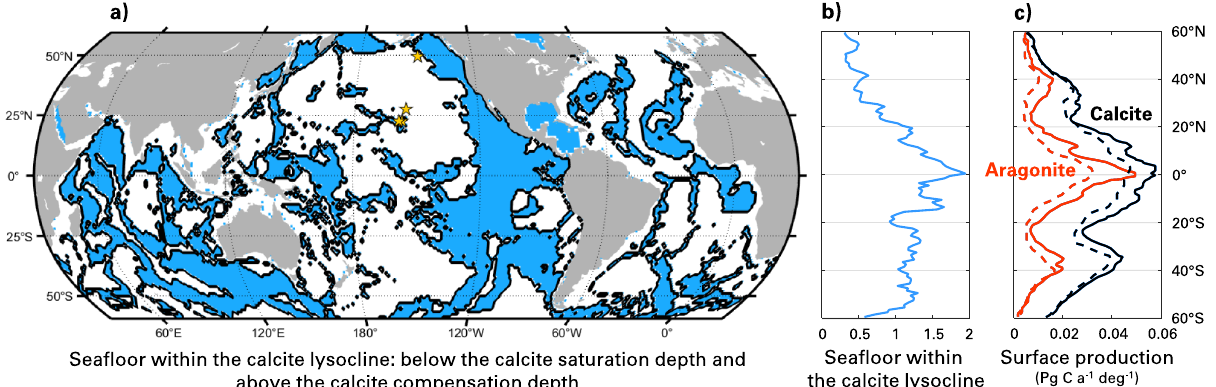
Fig. 4 Likely main loci of aragonite-based calcite galvanization. a Map showing in blue the surface area of sea fl oor that is located below the current calcite saturation depth and the preindustrial calcite compensation depth, i.e., the calcite lysocline; both fi elds are from ref. 30 . The four yellow stars in the North Paci fi c correspond to the three sites where ref. 31 observed aragonite in the water column below the aragonite saturation depth and the site where ref. 33 measured pteropod genetic material in bottom waters. b Zonal integral of the sea fl oor surface area within the calcite lysocline. c Zonal integrals of the surface productions of aragonite (in red) and calcite (in black) in the uppermost 100 m of the surface ocean in ESM2M (solid) and ESM2G (dashed), averaged over 100 yr after a 1000yr spinup; taken from ref. 17